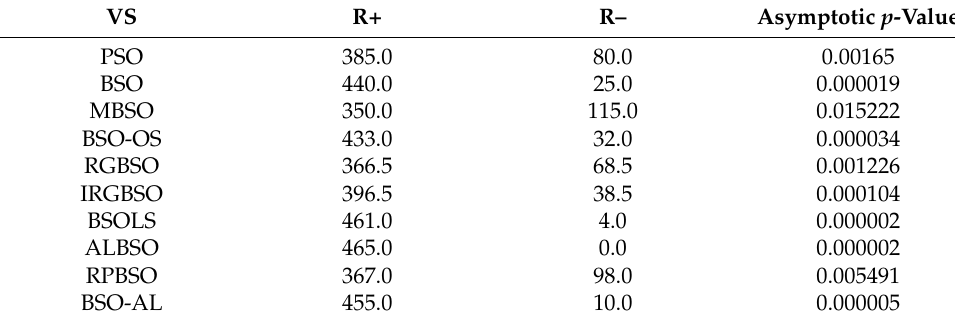
Table 13. Results obtained by the Wilcoxon test for algorithm BSONME.